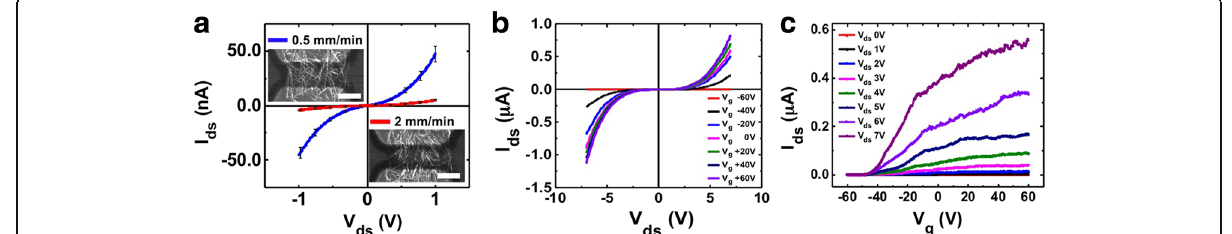
Fig. 3 Connectivity and electrical properties of ZnO NW network by control of pulling speed. a ZnO NWs network FET electrical properties of pulling speed 0.5 and 2 mm min − 1 . Typical current-voltage characteristics of devices fabricated at different pulling speeds of 0.5 and 2 mm min − 1 . The network channels showed Schottky contact from − 1 to 1 V. The insets are SEM images of network channel at 0.5 (top left) and 2 (bottom right) mm min − 1 . The scale bars are 10 μ m for both cases. b Current-voltage characteristics of various back-gate voltage. V g ranged from − 60 V to 60 V in 20 V steps. c I ds vs V g relations of ZnO NWs network channel fabricated at various V ds . V ds ranged from 0 to 7 V in 1 V